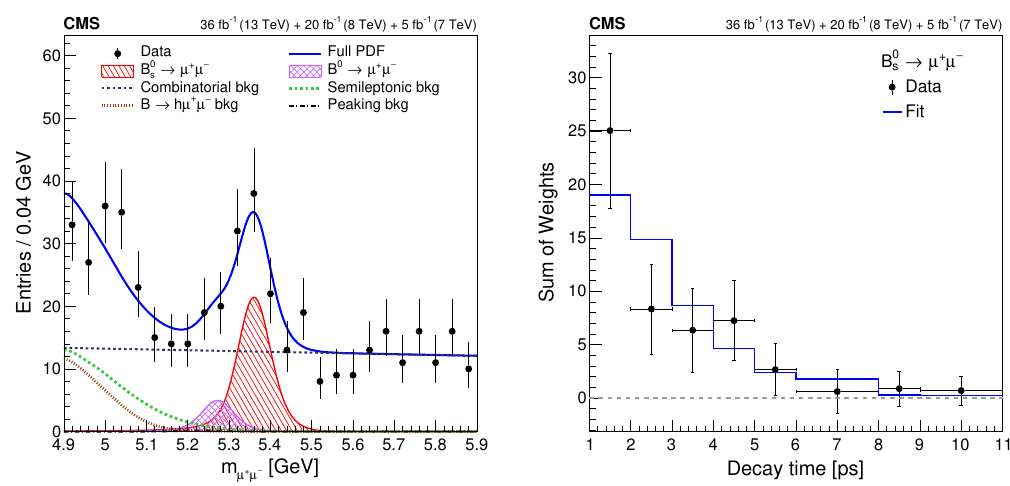
Figure 8 . Invariant mass (left) and proper decay time (right) distributions, with the sPlot (cid:12)t projections overlaid. The data combine all channels passing the analysis BDT discriminator re- quirements as given in table 4. For the mass distribution, no requirement on the decay time is applied. The total (cid:12)t is shown by the solid line, the di(cid:11)erent background components by the bro- ken lines and cross-hatched distribution. The signal component is shown by the single-hatched